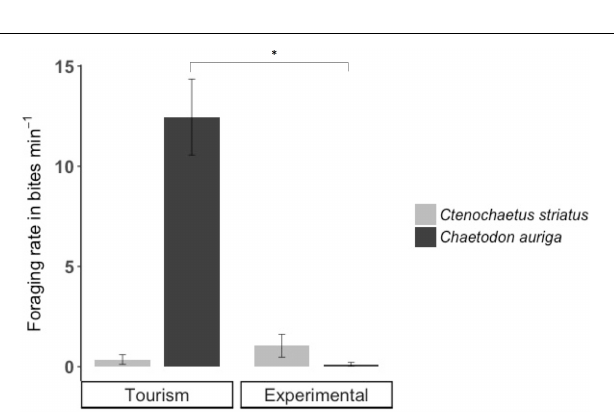
FIGURE 6 | Foraging rates ( ± SE) of Ctenochaetus striatus (light gray) and Chaetodon auriga (dark gray) on bread during bread feeding events. Significant differences are indicated by